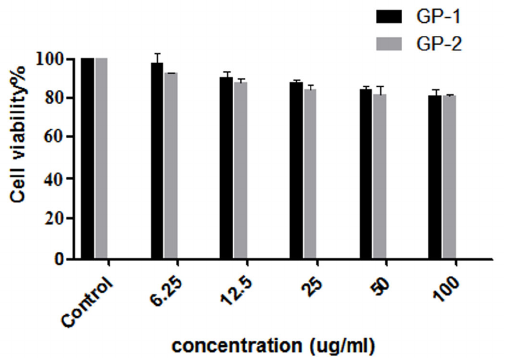
Figure 6. Effect of ginseng polysaccharides on cell